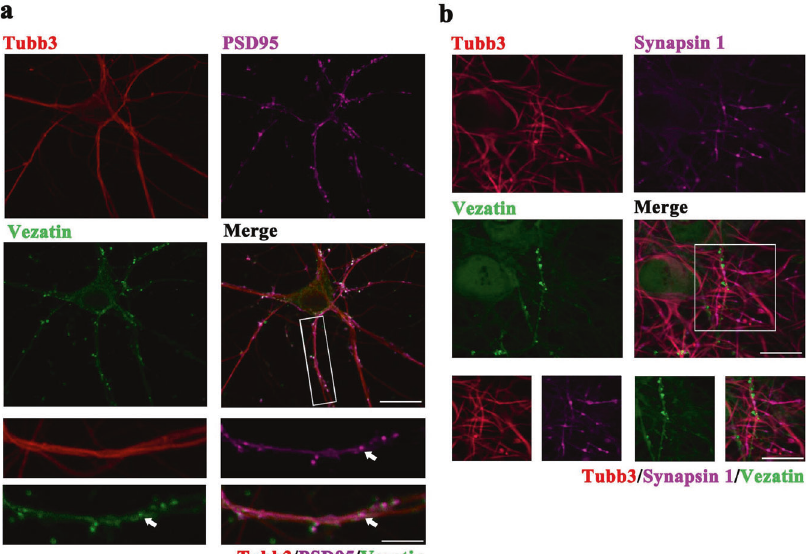
Fig. 2 The pattern of vezatin expression in hippocampal neurons in vitro. Representative images of immuno fl uorescence staining demonstrating that vezatin (green) was localized in neurons positive for the neuronal marker Tubb3 (red) and colocalized with the excitatory postsynaptic marker PSD-95 (purple) ( a ) but not with the excitatory presynaptic marker synapsin 1 (purple) ( b